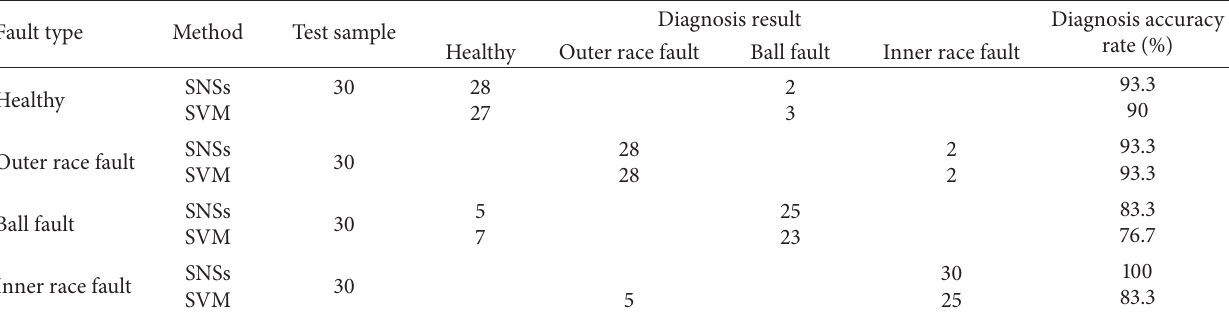
Table 5: Fault diagnosis results based on the correlation coefficient of SNSs and